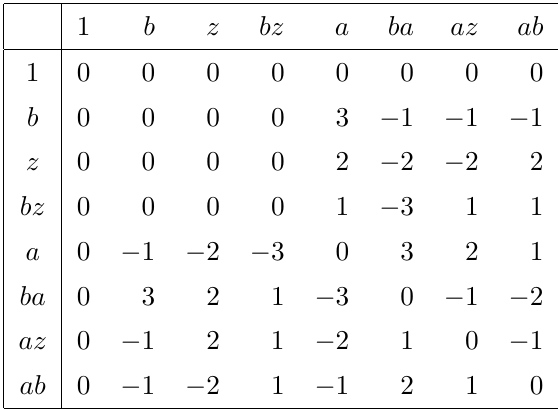
Table 7 . Table of values of n ( g, h ) , appearing in the cocycle representing the nontrivial element of H 2 ( D 4 , U(1))